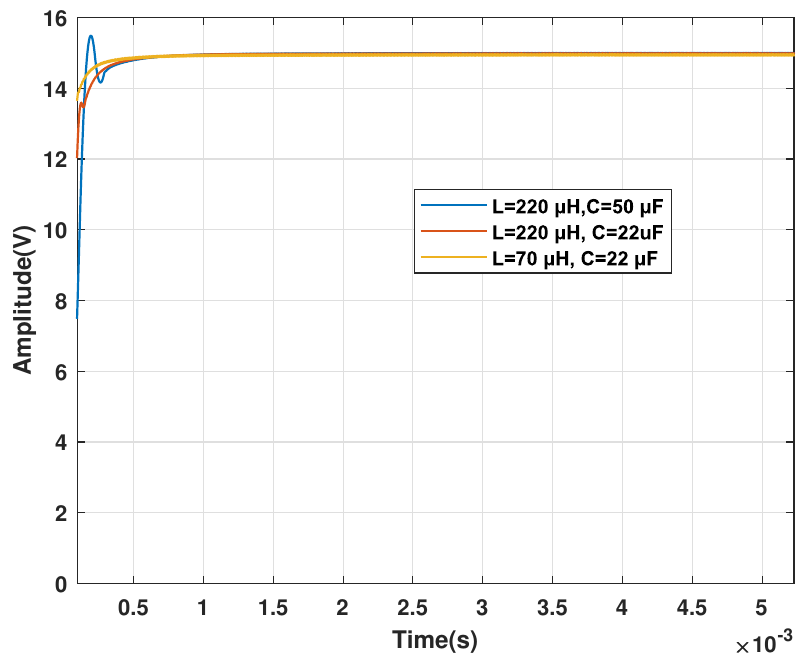
Figure 12. CI optimized system response to filter parameter